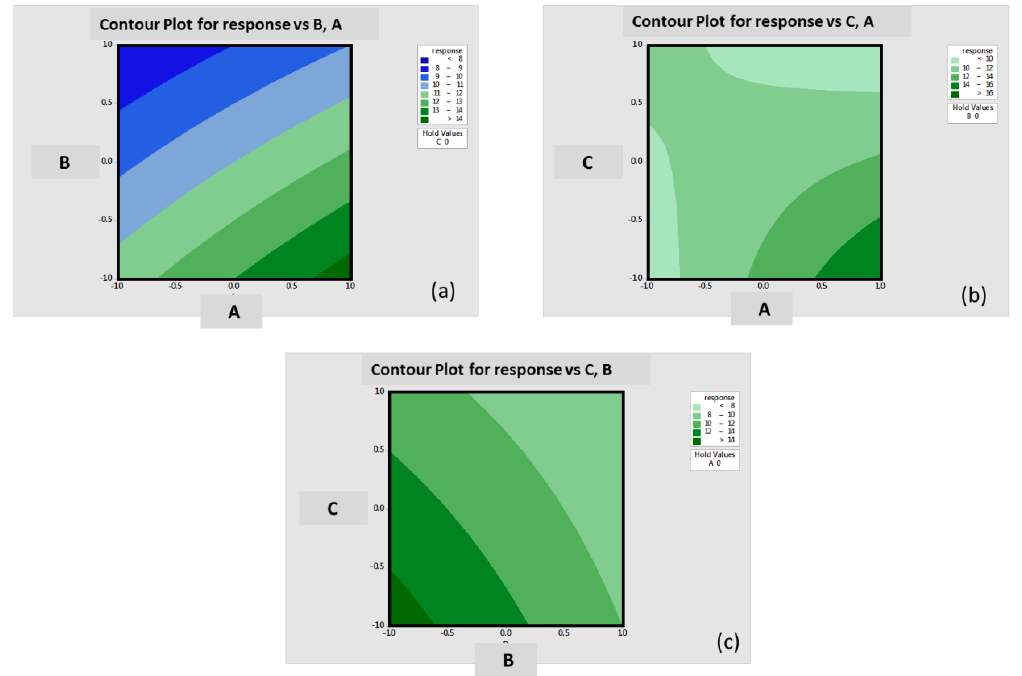
Figure A17. Contour plots for different variable vs. response (A = power, B = speed, C = thickness). ( a ) . Plot for response vs B, A ( b ) . Plot for response vs C, A ( c ). Plot for response vs C, B .